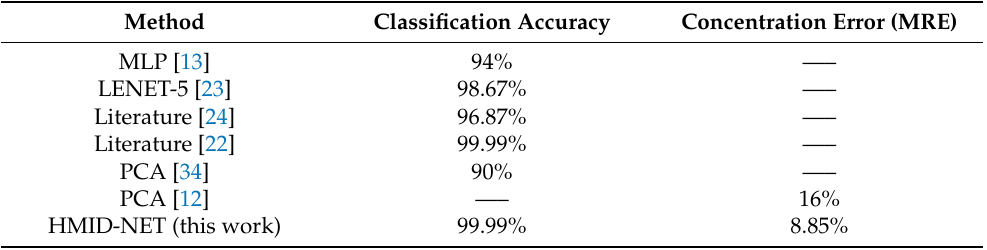
Table 2. Comparison of the detection accuracy of multiple data-processing